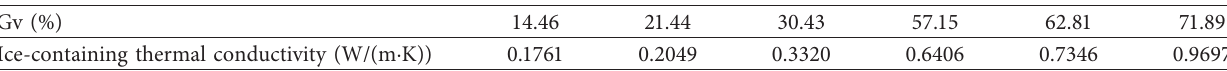
Figure 16: Air temperature at the entrance of the Yuximolegai tunnel Table 10: Ice-containing thermal conductivity of the phenolic thermal insulation board.